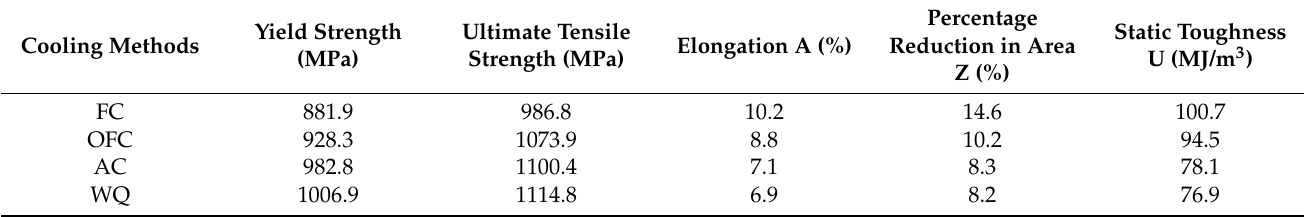
Table 2. Mechanical properties of TC21 alloy under different